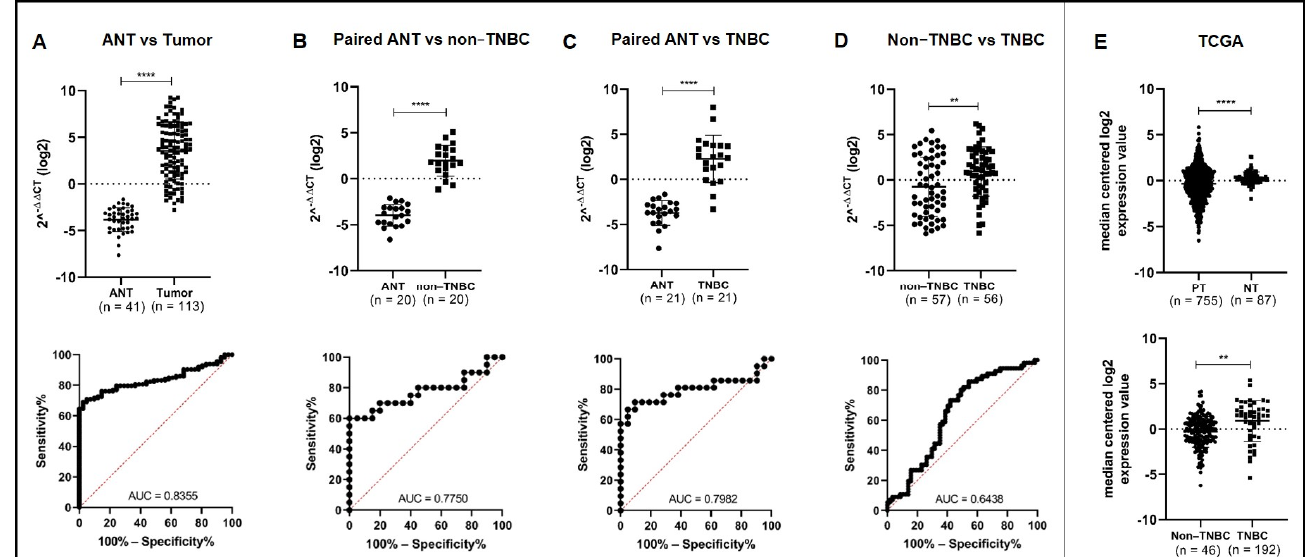
Figure 1. Expression levels (upper panel) by RT-qPCR and ROC/AUC values (lower panel) of miR-150-5p in the group of tumors and ANT tissues evaluated. Higher expression levels of miR-150- 5p were significantly observed in the tumor tissues vs. ANT ( A ), paired ANT vs. non-TNBC ( B ), paired ANT vs. TNBC ( C ), and non-TNBC vs. TNBC ( D ). Significant up-regulation of miR-150-5p expression levels by RNAseq in from the TCGA breast cancer cases were observed in primary breast tumors when compared to normal breast tissue (( E ) upper panel) and TNBC vs. non-TNBC cases (( E ), lower panel). ANT: adjacent non-tumor tissue; PT = primary tumor; NT = normal tissue. Statistical significance ** p < 0.01, **** p <